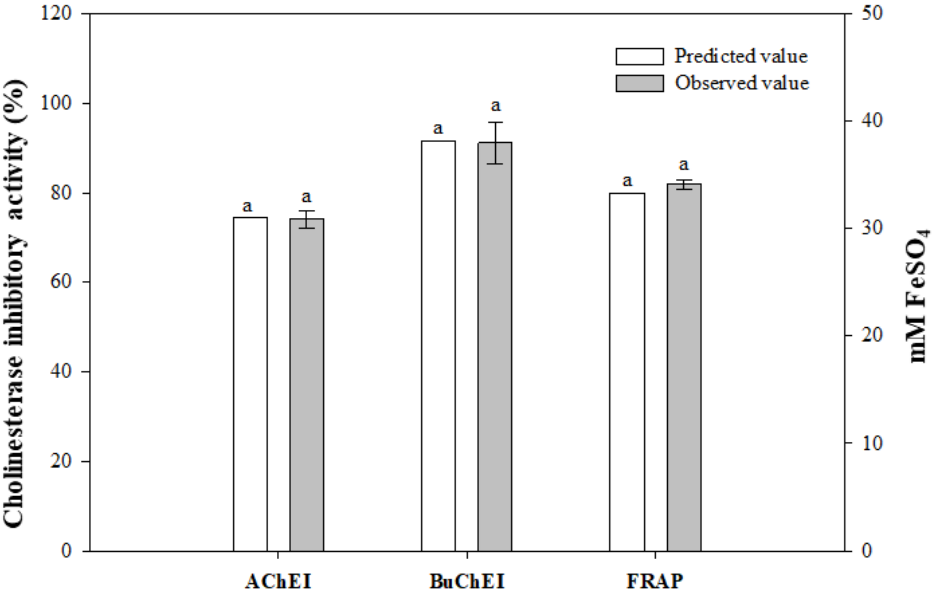
Figure 6. Comparison of predicted and observed values of MKJW-fermented A. capillaris. Same letters between the predicted and observed value are not significantly different ( p > 0.05)